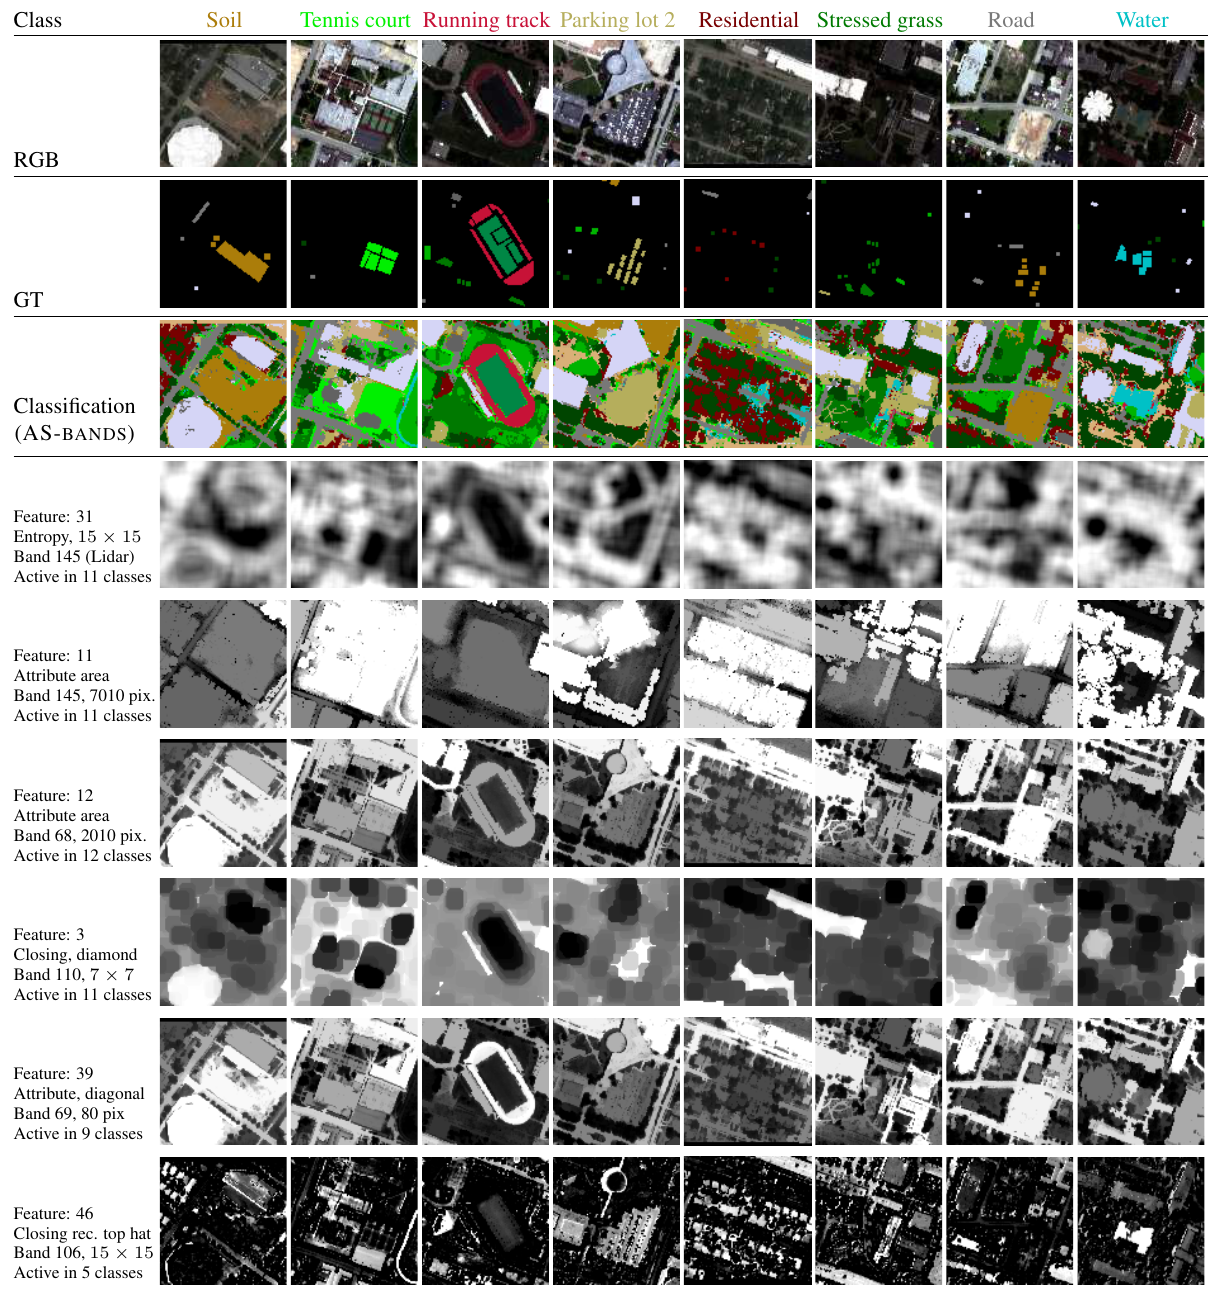
Figure 7: Visualization of the features with highest || W j, · || 2 for one run of the H OUSTON 2013 results (cf. bottom matrix of Fig. 6). First row: RGB subsets; Second row: ground truth; Third row: output of the classification with the proposed approach; Fourth row to end: visualization of the six features with highest squared